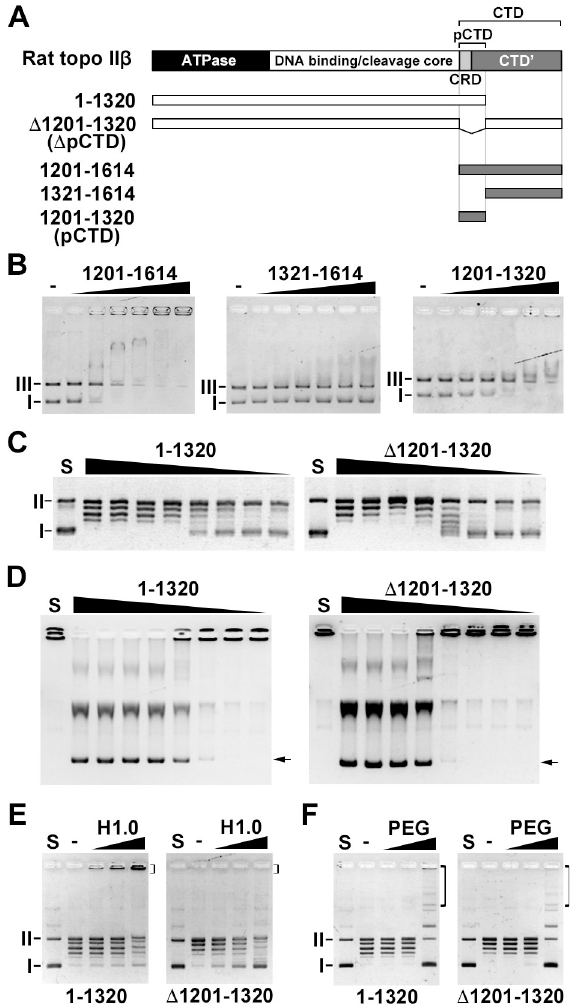
Fig 2. The DNA binding activity of the rat topo II β 1201–1320 region (pCTD) contributes to efficient in vitro catenation. (A) Scheme of rat topo II β CTD (1201–1614) and its truncation mutants used in this study. (B) GST- tagged proteins (100, 200, 300, 400, 500, and 600 fmol) were mixed with 5 ng supercoiled and linearized pUC18 and incubated for 30 min. The reaction mixture was subjected to 1% agarose gel containing MgCl 2 . (C) The relaxation assay was performed as described in Fig 1. (D) The decatenation assay was performed as described in Fig 1. Arrows indicated decatenated DNA bands. (E) The catenation assay was performed in the presence of H1.0 (1, 2, and 4 μ g/mL) as described in Fig 1. (F) Catenation assay in the presence of PEG (1%, 5%, and 10%) as described in Fig 1. I: supercoiled DNA. II: nicked circular DNA. III: linearized DNA. Brackets indicate catenanes.